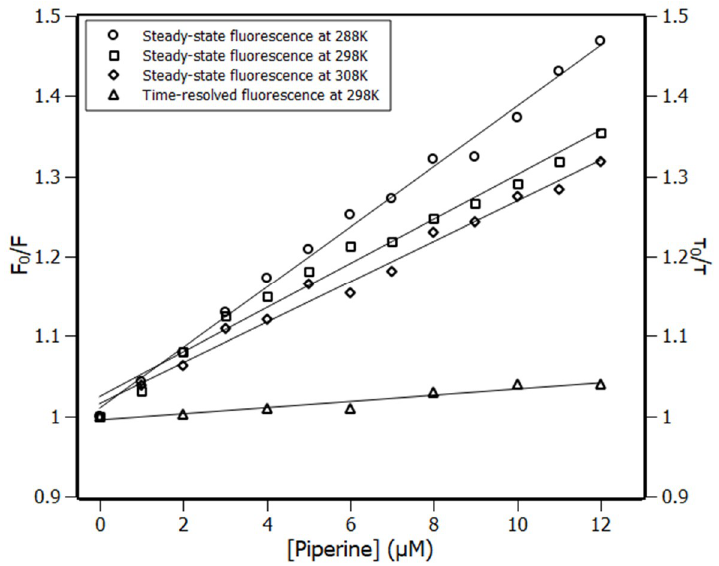
Figure 2. Left ordinate Stern–Volmer plots at three temperatures, 288 K, 298 K, and 308 K, and right ordinate time-resolved fluorescence lifetime plot at 298 K; [RSA] =4 µM, [piperine]=0–12 µM.